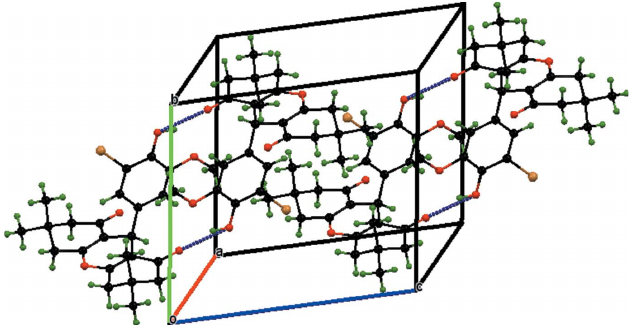
Figure 3 Packing view for (I), showing the formation of O—H (cid:3)(cid:3)(cid:3) O hydrogen bonds between molecules in the unit cell. (20) ring motif. 2